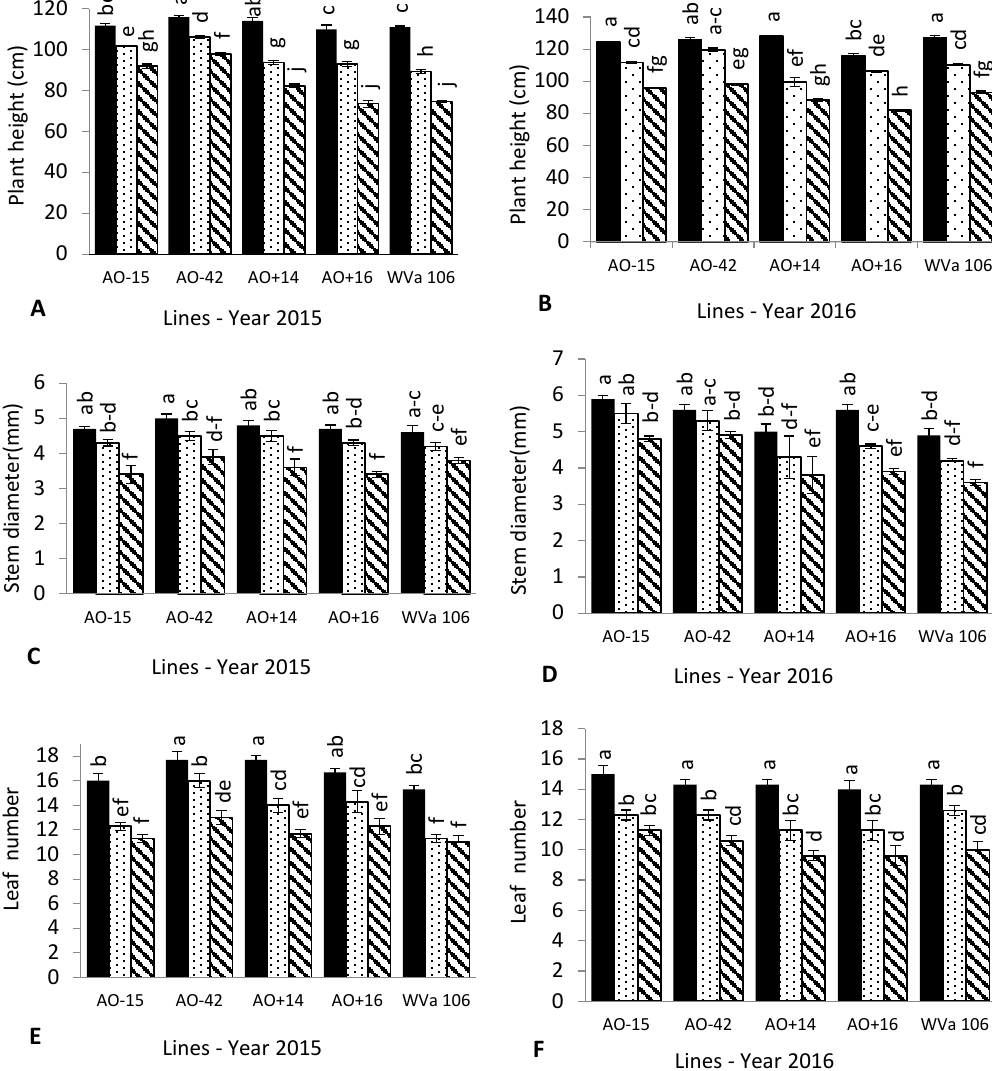
Figure 2. The effect of three salinity levels 0 mM (black bars), 75 mM (speckled bars), and 150 mM NaCl (striped bars) on cherry tomato lines. ( A ) Plant height in 2015, ( B ) plant height in 2016, ( C ) stem diameter in 2015, ( D ) stem diameter in 2016, ( E ) leaf number in 2015, and ( F ) leaf number in 2016. Results with the same superscript were not significantly different ( p < 0.05) according to the classification obtained by the Duncan test.